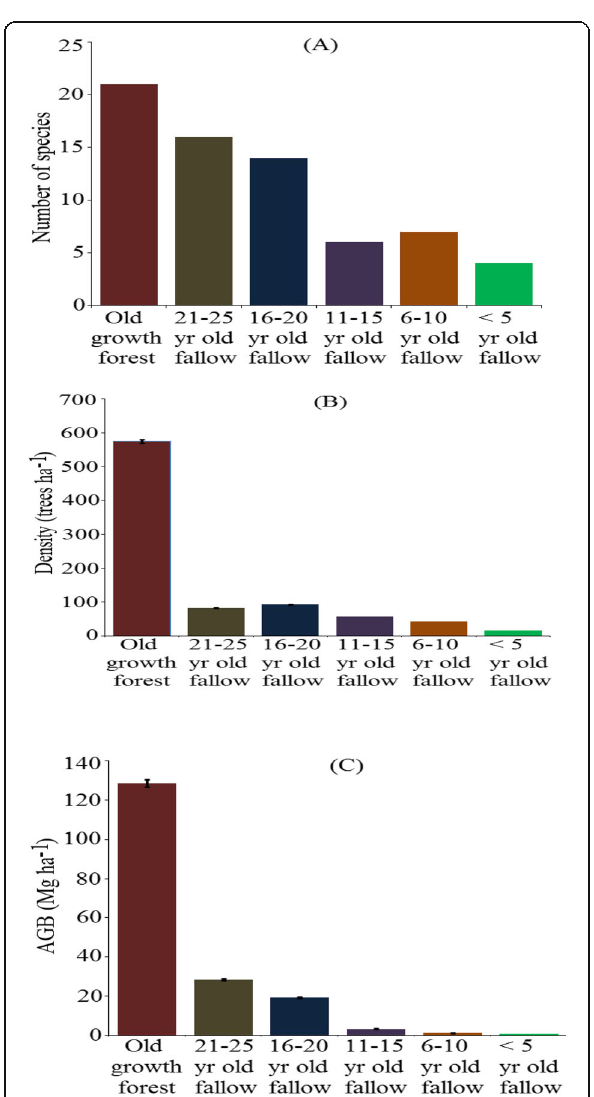
Fig. 2 The number ( a ), density ( b ), and aboveground biomass (AGB) ( c ) of dominant species in each jhum and old-growth forest (data are presented mean ± standard error, n = 3; vertical bar represents standard error). The dominant species are explained in Additional file 1. The symbols *, @, %, #, $, and © represent dominant species